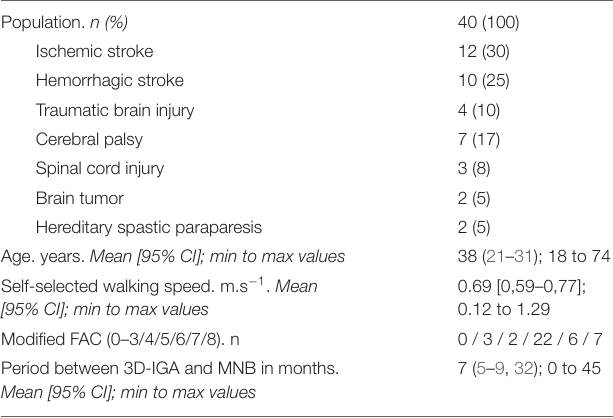
TABLE 1 | Detailed population characteristics ( n = 41). Population. n (%) 40 (100) Ischemic stroke 12 (30) Hemorrhagic stroke 10 (25) Traumatic brain injury 4 (10) Cerebral palsy 7 (17) Spinal cord injury 3 (8) Brain tumor 2 (5) Hereditary spastic paraparesis 2 (5)